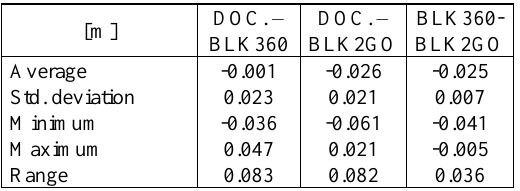
Table 4 . Comparison of lengths (number of observation = 30).